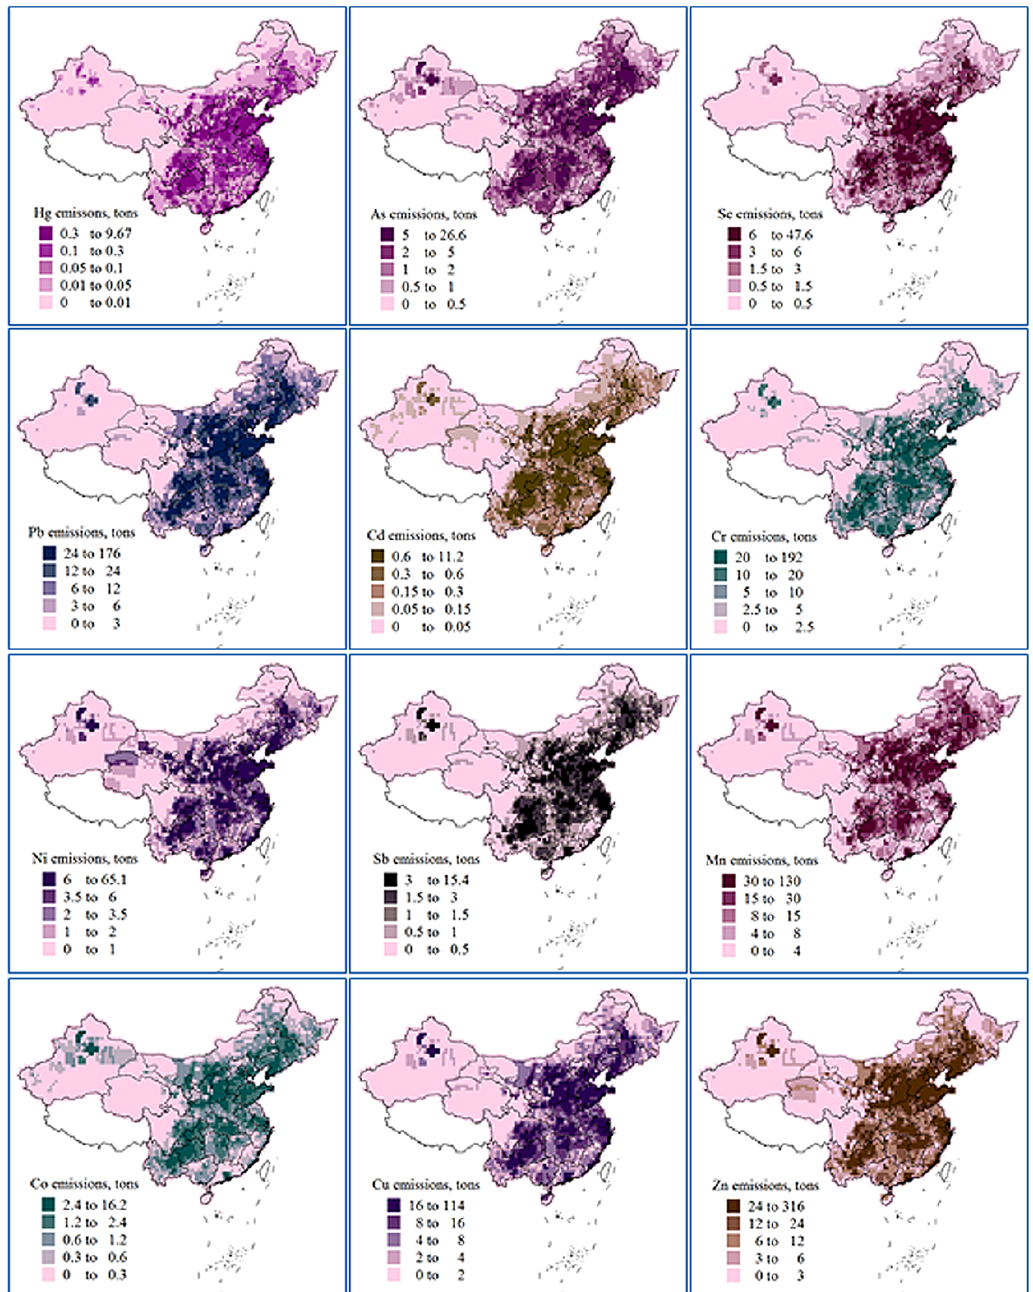
Figure 5. Gridded HM emissions from anthropogenic sources for the year 2010 (0.5 ◦ × 0.5 ◦ resolution; units, kilograms per year per grid